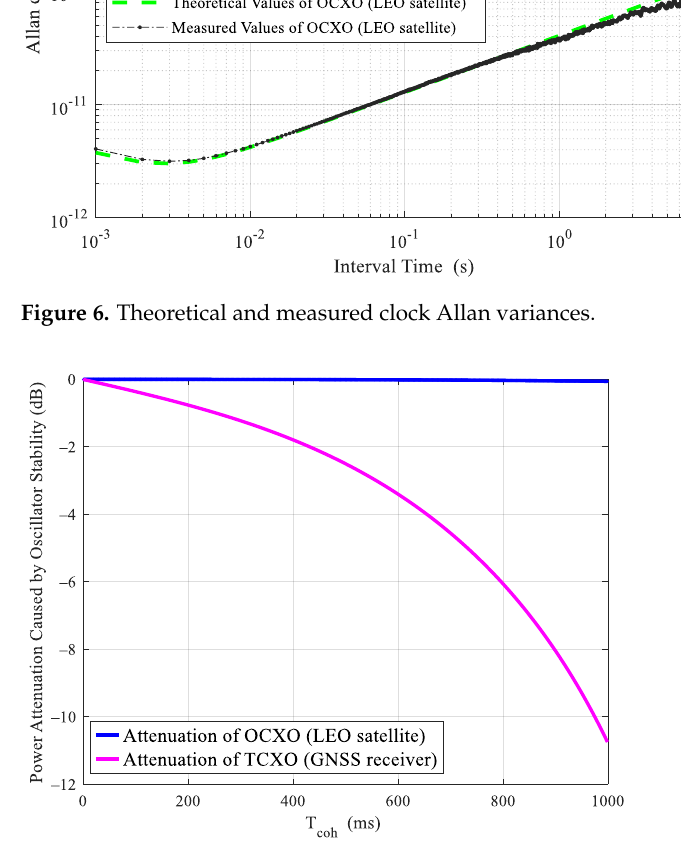
Figure 7. Power attenuation caused by oscillator stability.